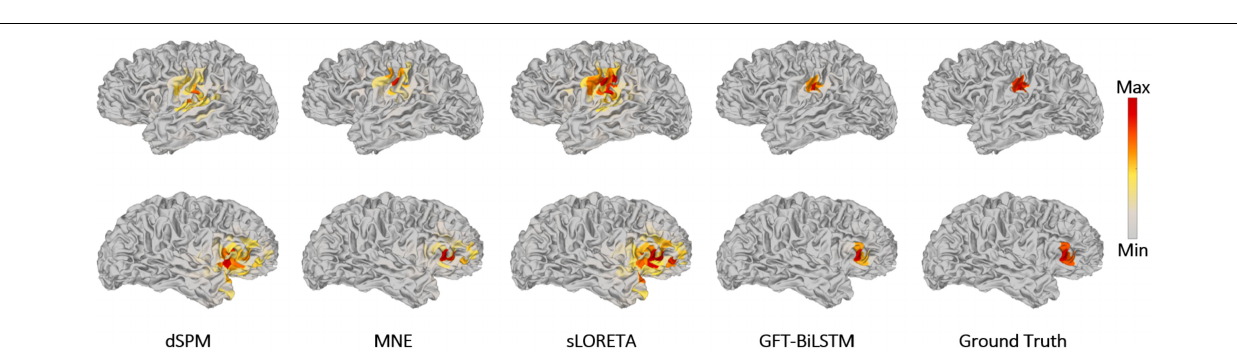
FIGURE 8 | Brain source activation reconstructed by different ESI algorithms with multiple activated areas. The upper figures correspond to the activated area in the left side of the brain, the bottom figures correspond to the activated area in the right side of the brain.